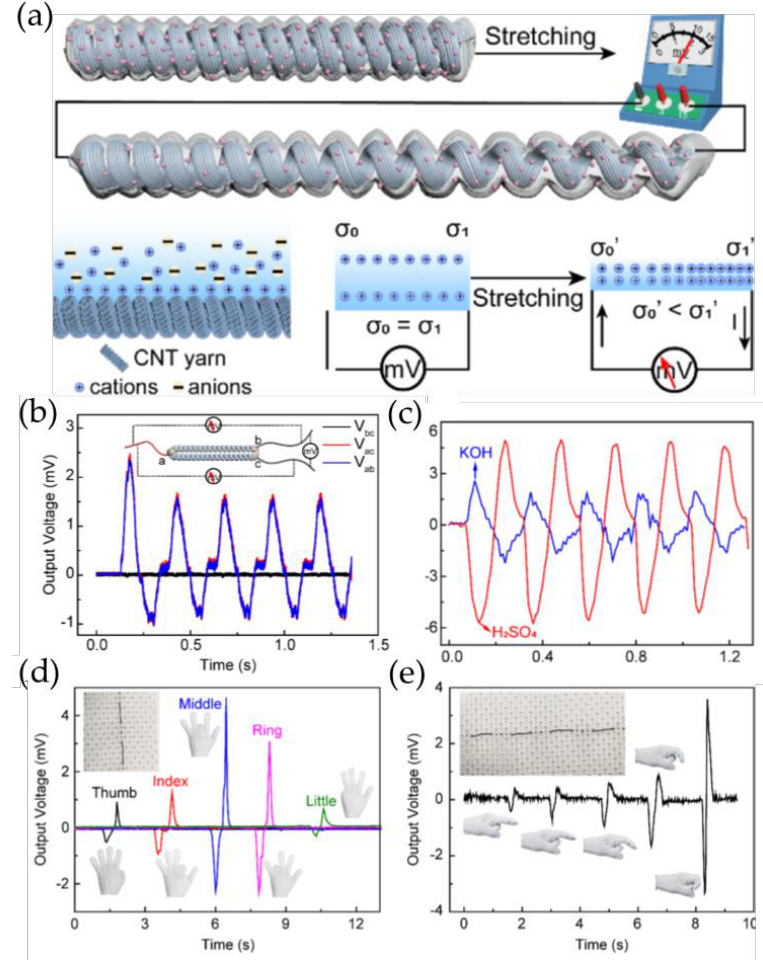
Figure 8. ( a ) Schematic illustration of the mechanism of the voltage generated by dynamic structure- nonuniform-induced ion squeezing. ( b ) Output voltage resulting from the two-end-symmetry-stretch tests conducted on the coiled CNT@PVA/H 2 SO 4 yarn, with the middle portion secured while both ends are simultaneously stretched. ( c ) The output voltage signal of CNT@PVA/H 2 SO 4 and CNT@PVA/KOH yarns with reversed phase. ( d ) The output voltage signal of the sensors attached on each finger of a hand with different finger motions. ( e ) Signal generated by the bending of an index finger at varying degrees. (Reprinted with permission from [79] .)